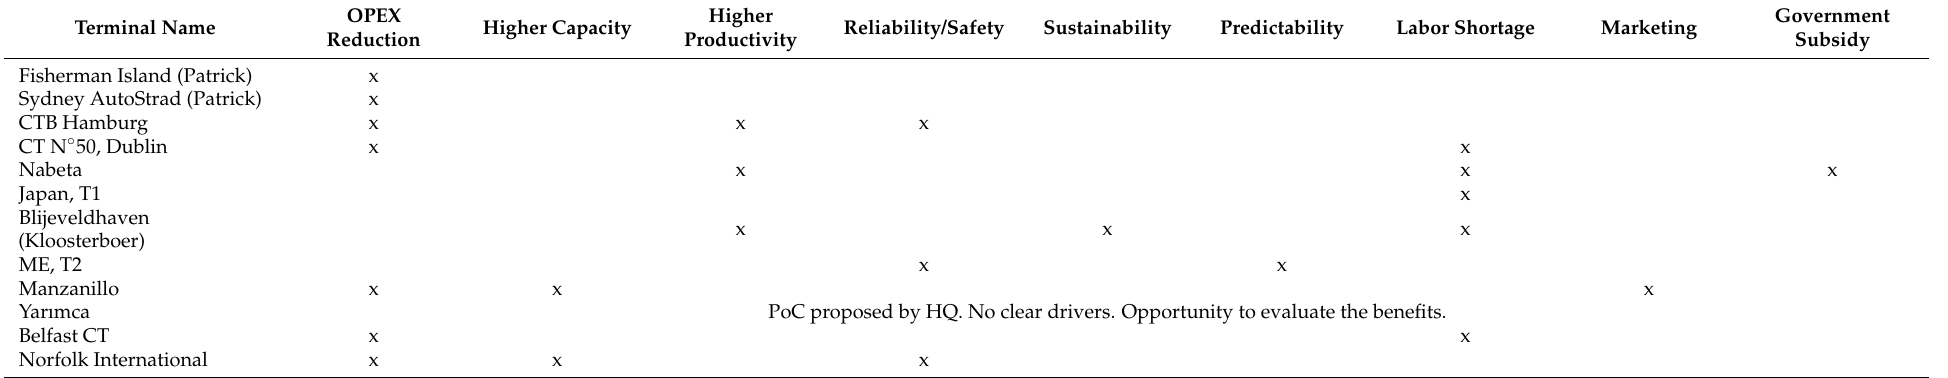
Table A1. Drivers for converting to automated operations identified from questionnaire responses.